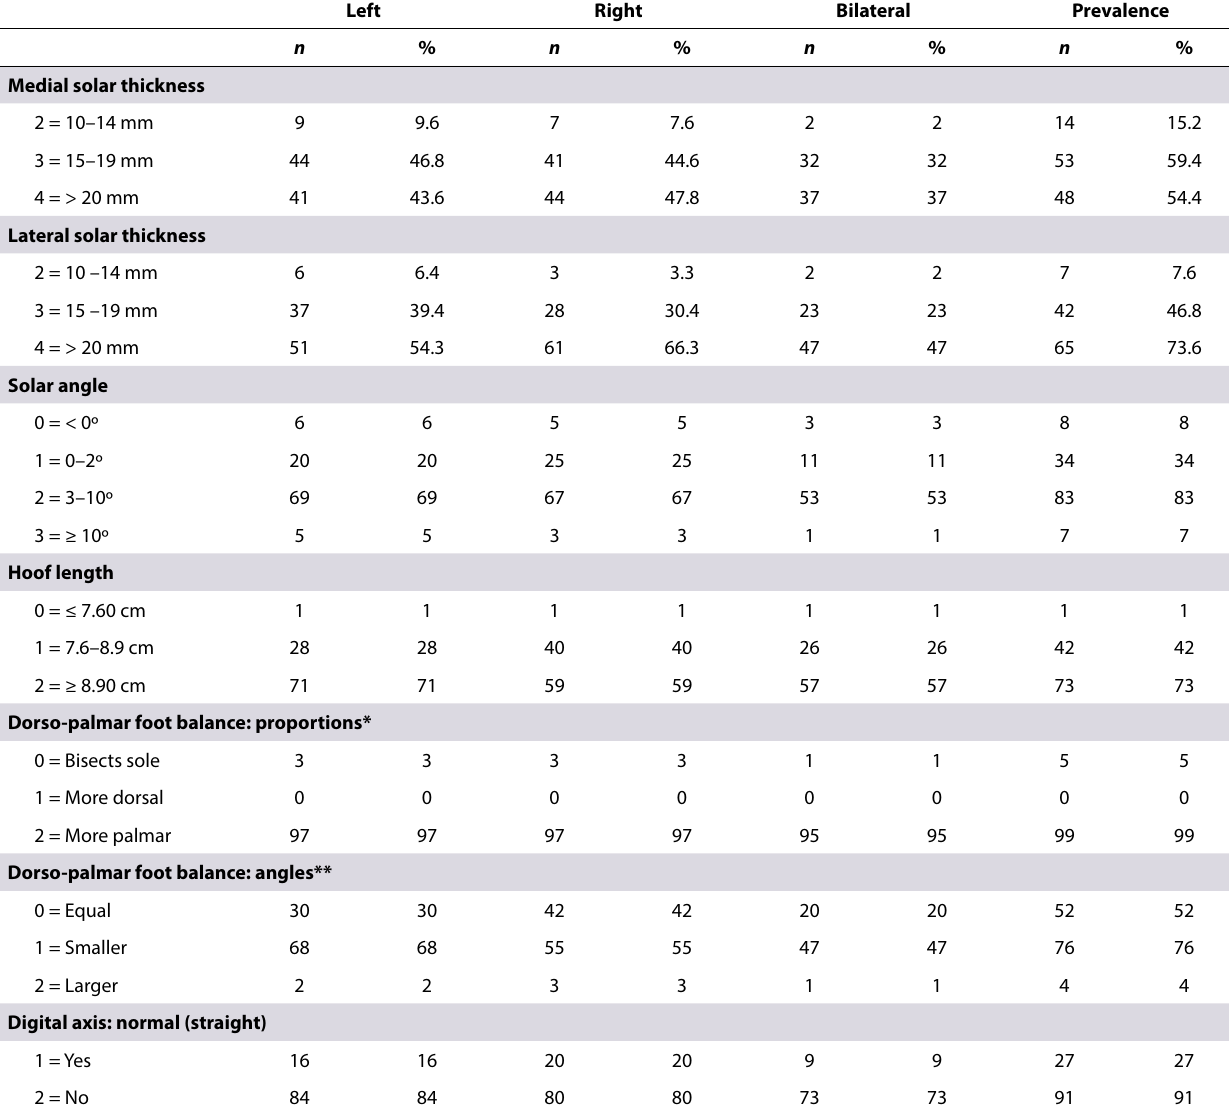
Table I: Radiographic changes in the digit of endurance racehorses ( n = 100) Left Right